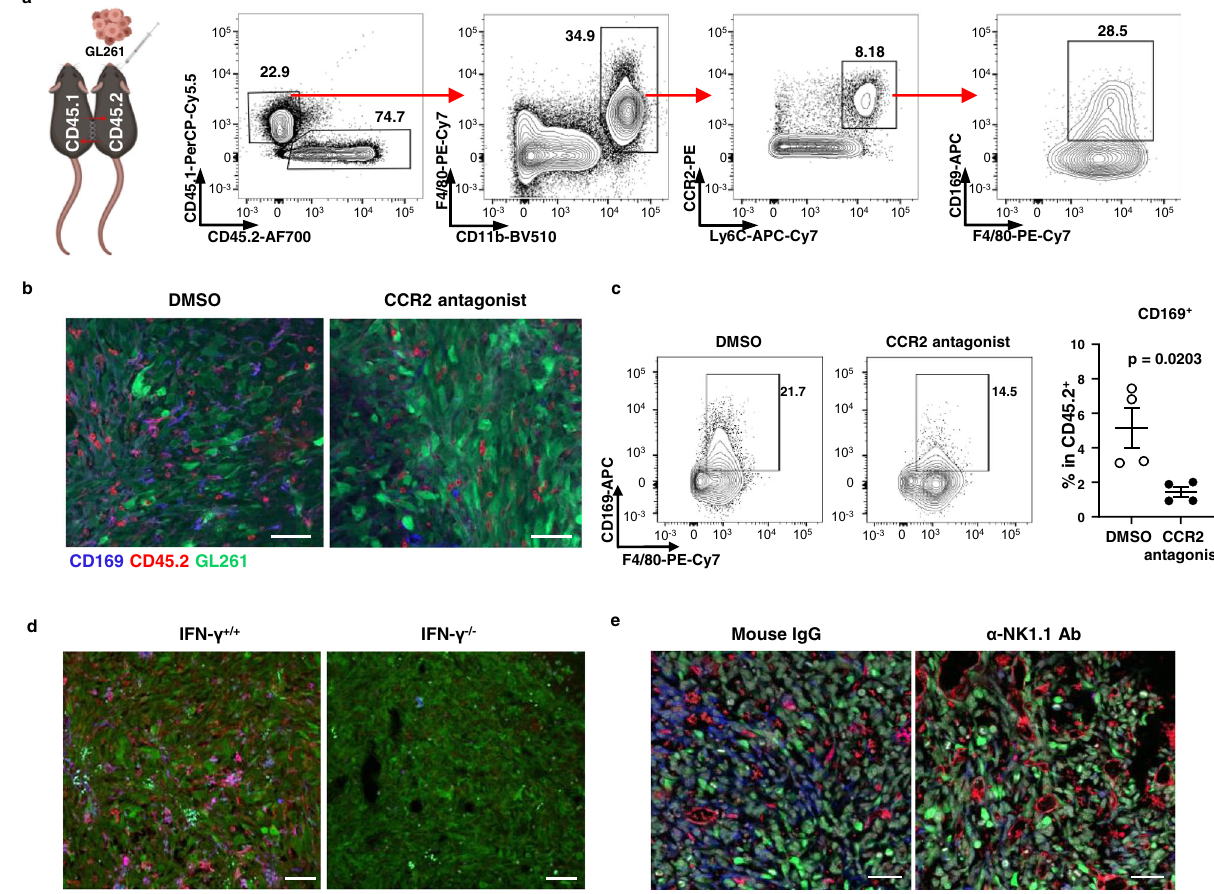
Fig. 5 | IFN- γ production by NK cells is critical for the tumor in fi ltration of monocyte-derived in fl ammatory macrophages. a CD45.2 mice ( n =3) were connected by parabiosis to CD45.1 mice ( n =3) and injected with GL261. Immune cellsfromthetumorwereanalyzedat20dpiby fl owcytometry.Theboldnumbers intheplotsindicatethepercentageofgatedcells.Datarepresenttwoindependent experiments. Figure for parabiosis experiment scheme was created with BioR- ender.com. b , c C57BL/6Jmalemiceweretreatedwith5mg/kgofCCR2antagonist every 3 days starting one day before GL261-GFP injection. DMSO was injected as a control. In fi ltration of CD169 + macrophages into gliomas was analyzed by b confocalmicroscopyat10dpi( n =3foreachgroup)or c fl owcytometryat15dpi ( n =4foreachgroup). b Scalebarindicates50 μ m. c The p -valuewascalculatedby